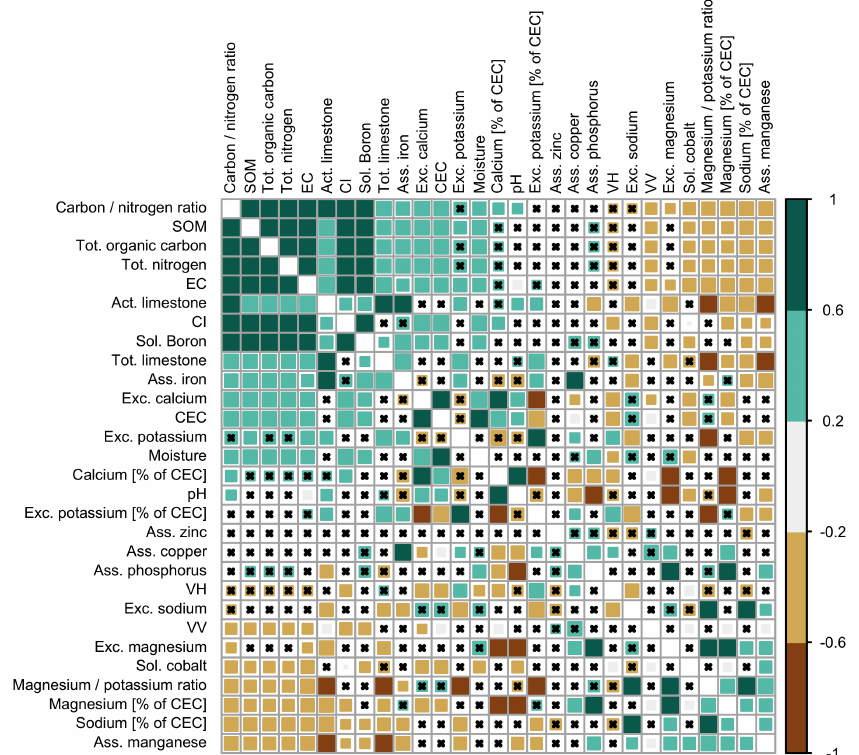
Figure 4. Correlation matrix among exploratory variables. Correlation values are color-coded as squares whose size is proportional to their significance, insignificant ( p < 0.01) correlation values are struck with a black cross. VV: backscatter of single co-polarization, Vertical transmit/Vertical receive, VH: backscatter of Vertical transmit/Horizontal receive polarisation. See Table 1 for soil